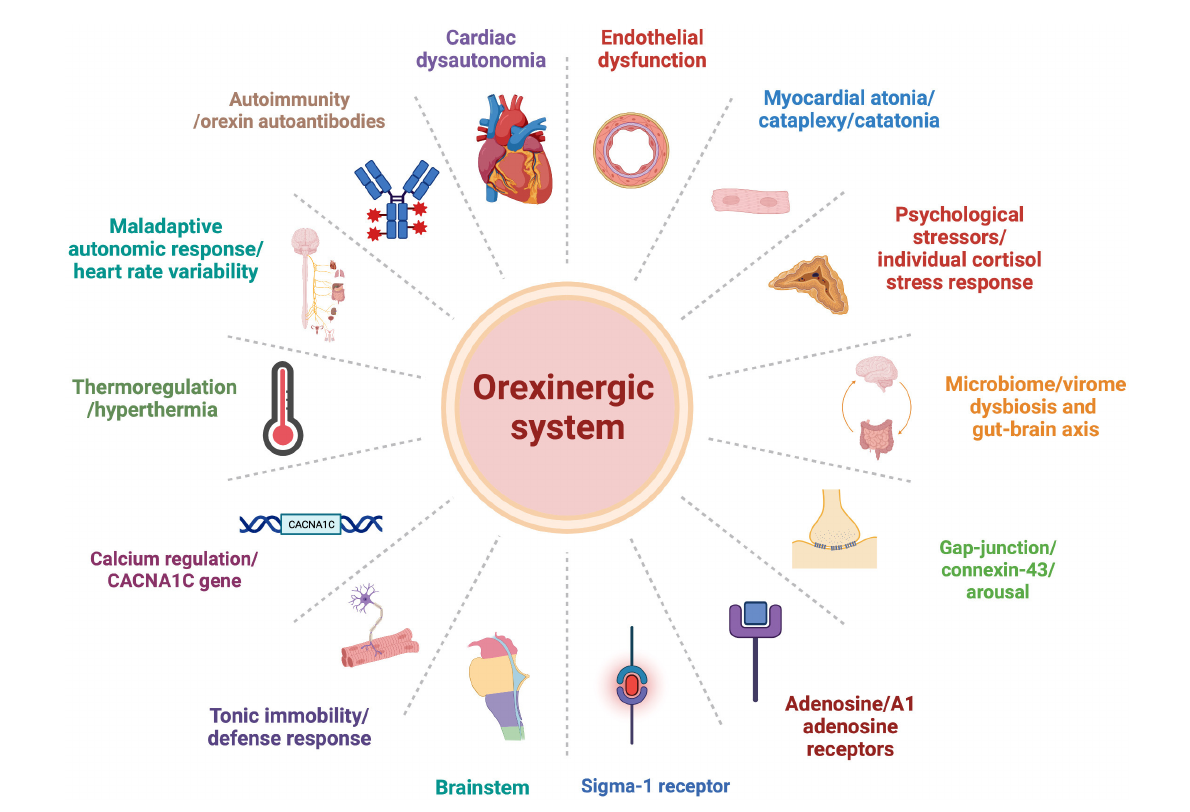
(BROKEN SWEDEHEART NCT04666454) is